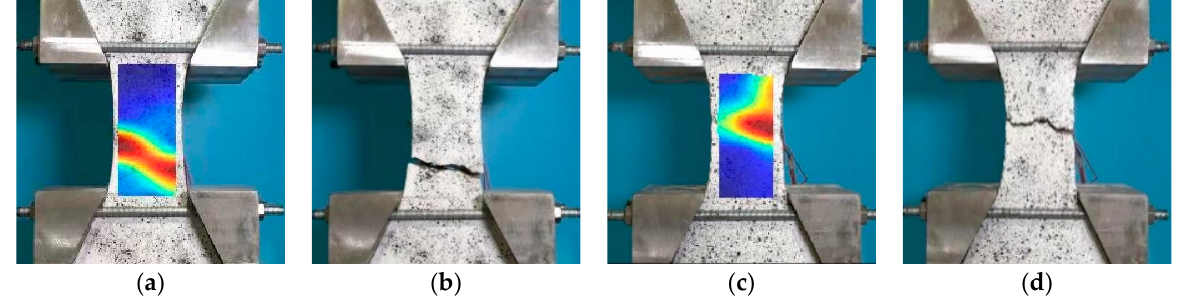
Figure 12. Comparison of specimen fracture and DIC digital imaging. ( a ) 40 °C—0.1 s before crack, ( b ) 40 °C—crack, ( c ) 60 °C—0.1 s before crack, ( d ) 60 °C—crack.